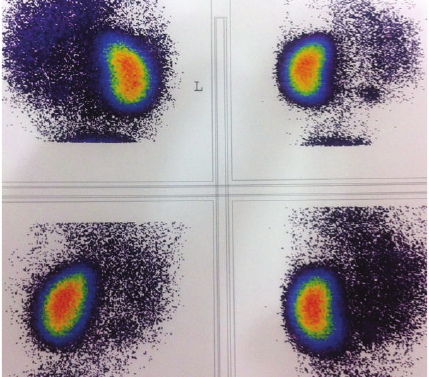
Figure 3: DMSA scan showed severely decreased right kidney uptake that is compatible with right dysplastic kidney with normal left kidney